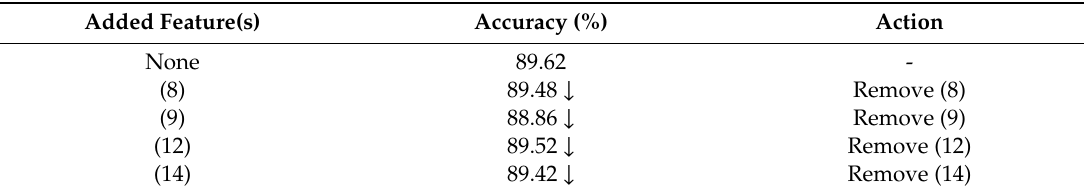
Table 3. Accuracy variation during the “forwards” procedure.